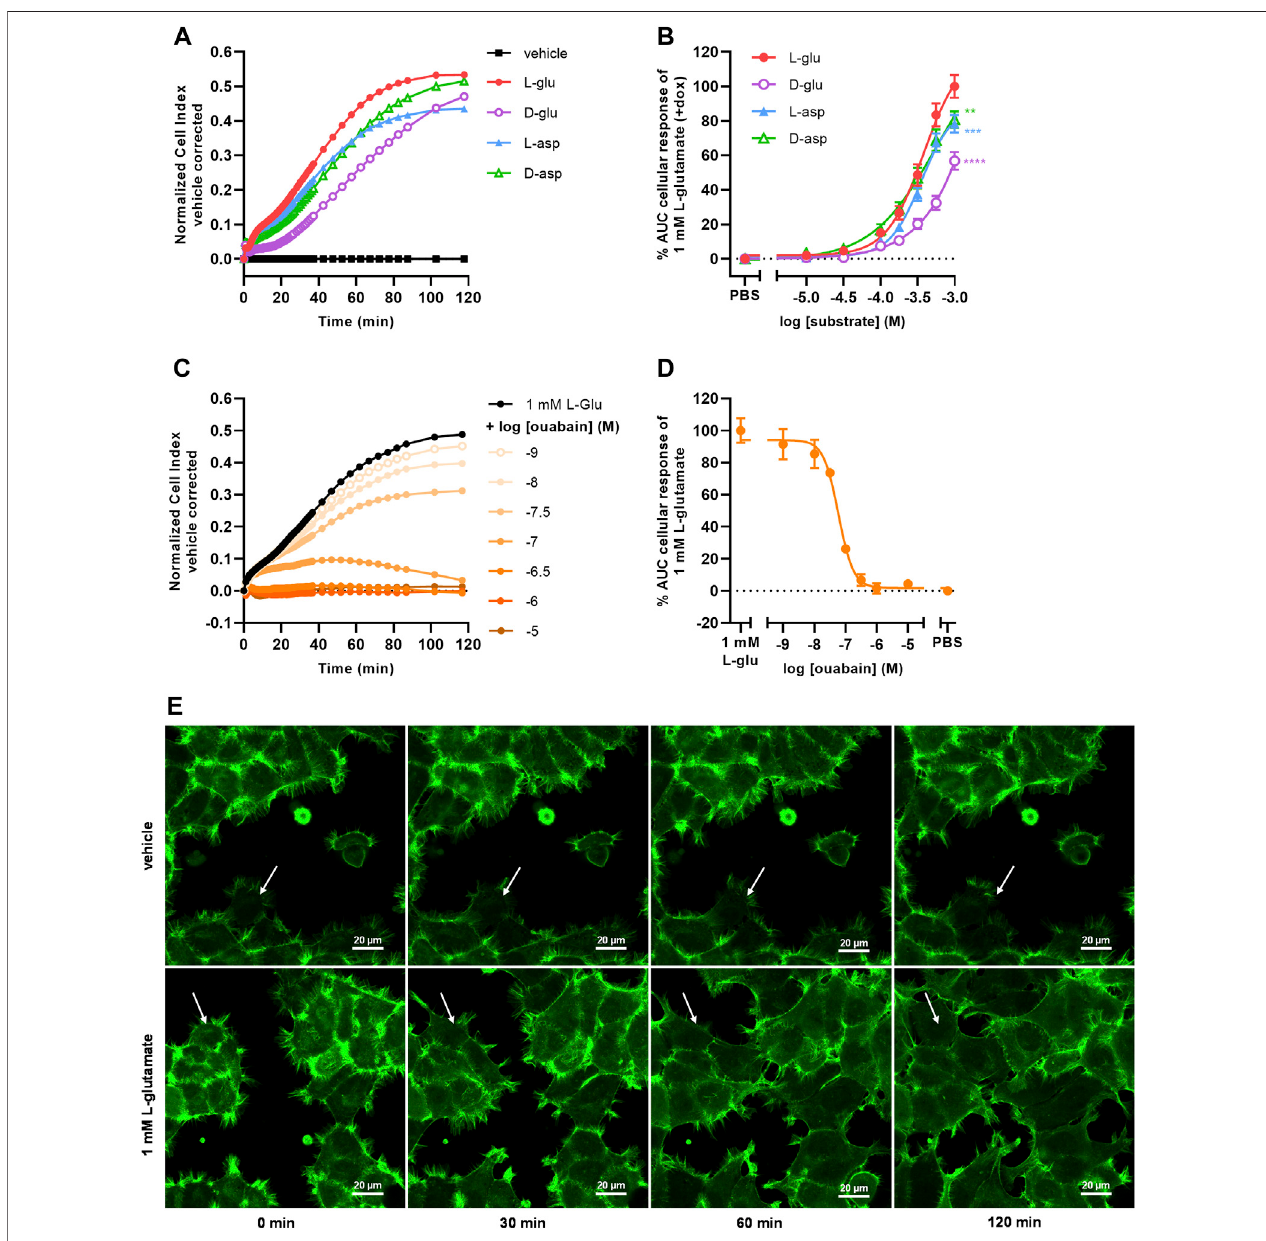
FIGURE 3 | Substrate-dependent uptake via EAAT1 mediates Na + /K + -ATPase (NKA)-dependent cell spreading. (A) Vehicle-corrected nCI traces of +dox cells stimulated with vehicle (PBS), 1 mM of L-glutamate (L-glu), D-glutamate (D-glu), L-aspartate (L-asp) or D-aspartate (D-asp), shown as the mean of a representative experiment performed in duplicate. (B) Combined concentration-response curves of L-glu (derived from Figure 2D ), D-glu, L-asp and D-asp on +dox cells. (C) Vehicle (PBS)-corrected nCI traces of +dox cells pretreated for 1 h with vehicle (PBS/DMSO, black) or increasing concentrations of ouabain and subsequently stimulated with 1 mM L-glu, shown as the mean of a representative experiment performed in duplicate. (D) Combined concentration-inhibition curves of ouabain in +dox cells. Vehicle (PBS)-induced responses were subtracted from L-glu-induced responses for each concentration of ouabain. Cellular response is expressed as the net AUC of the fi rst120 minaftersubstratestimulation.Dataarenormalizedtotheresponseof1 mML-glu.Dataareshownasthemean±SEMofthreetosixindividualexperiments each performed induplicate. (E) Representative confocal images of JumpIn-EAAT1-LifeAct-GFP (green) cells 0, 30,60,and 120 min after stimulation withvehicle(PBS) or 1 mM L-glu, scale bar = 20 µm. Stills were selected from a representative live imaging movie from two independent experiments each performed in triplicate. White arrow indicates representative behavior of a single cell, showing increased cell spreading over